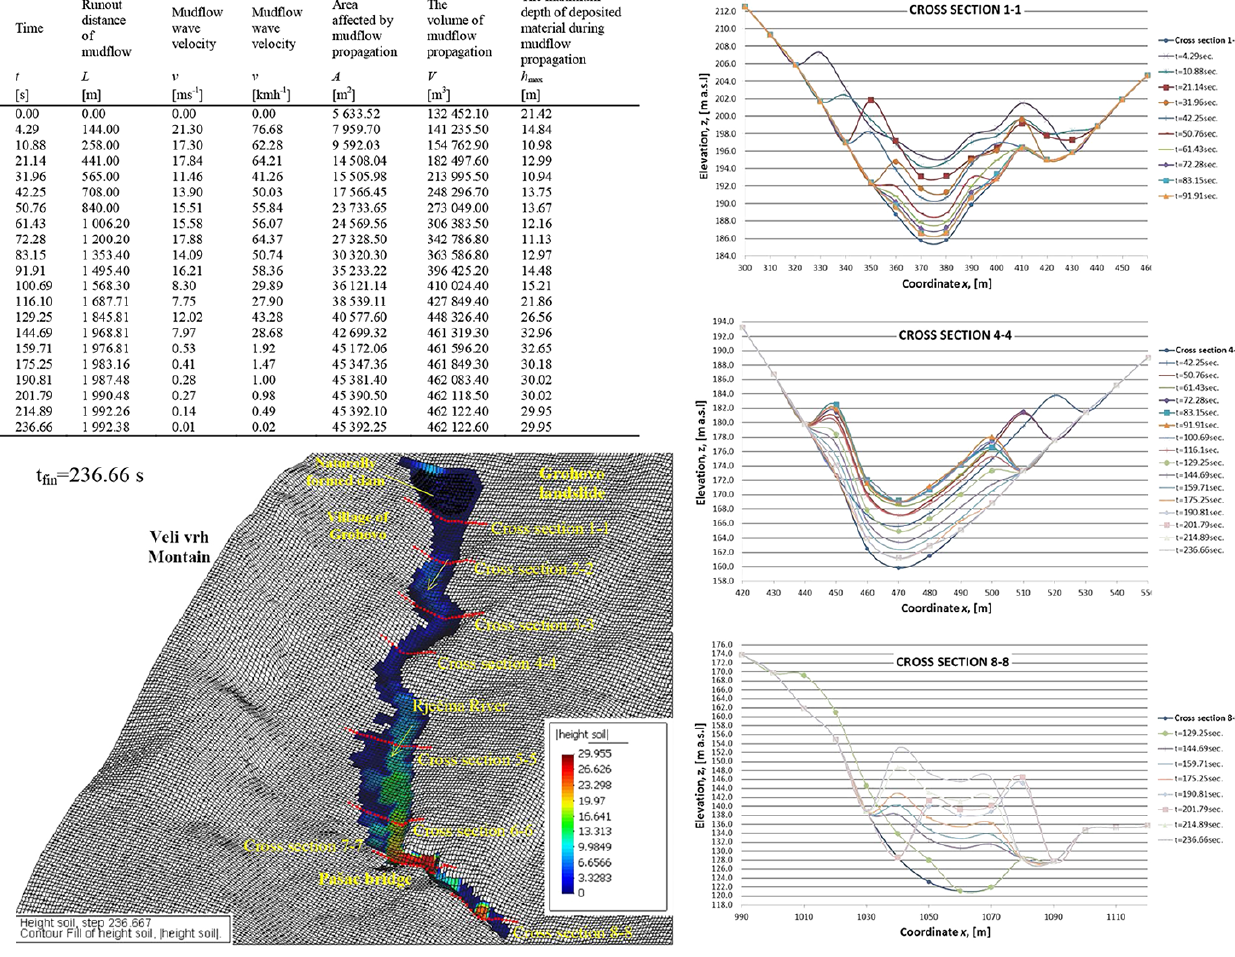
Figure 12. The results of the mudflow propagation on the Rjeˇcina River (based on the equidistant mesh grids of 5m × 5m), with propagation of materials from a natural dam formed on the Grohovo landslide, Simulation